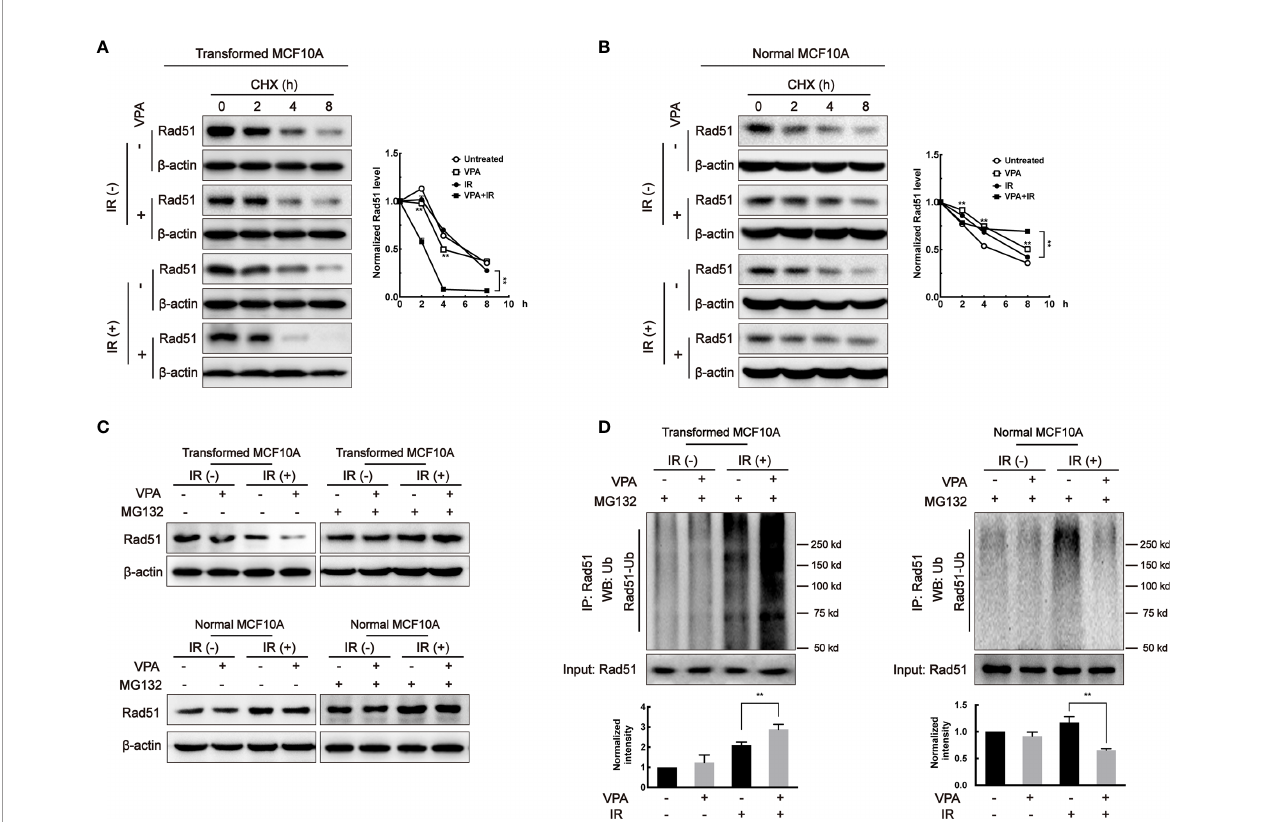
FIGURE 3 | VPA affects Rad51 stability and ubiquitination. After VPA and IR treatments, (A) transformed MCF10A cells and (B) normal MCF10A cells treated with 40 m g/ml CHX for 0, 2, 4, and 8 h. The expression of Rad51 was detected by Western blot. Cells treated with 40 m M MG132 at 6 h before whole-cell extracts harvesting. (C) Rad51 protein expression was detected by Western blot and the (D) ubiquitination on Rad51 was detected by immunoprecipitation. Bands in the graphs were quanti fi ed by ImageJ software (Wayne Rasband). Each data point in the graphs was from three independent experiments (mean ± SD); P -values were calculated by t-test (** P <